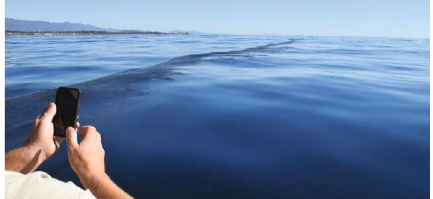
Figure 2: Thick oil slick from the Coal Oil Point (COP) seep fi eld. This slick stretched for kilometers. Similar COP slicks have been used for spill science, including dispersant tests [91] and studying oil slick advection [6]. Photo: Ira